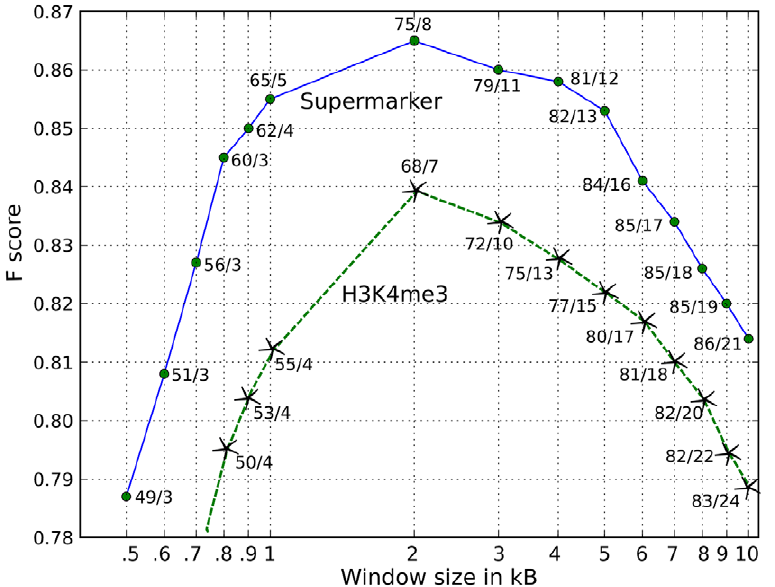
Figure 4. Influence of window size on the F score. Association (F score) between MLV proviruses [43] and either H3K4me3 (green dashed line with stars) or the supermarker in HeLa cells (solid blue line with solid circles) as a function of window size in kilobases. The true positive fraction versus the false positive fraction is shown for each point.